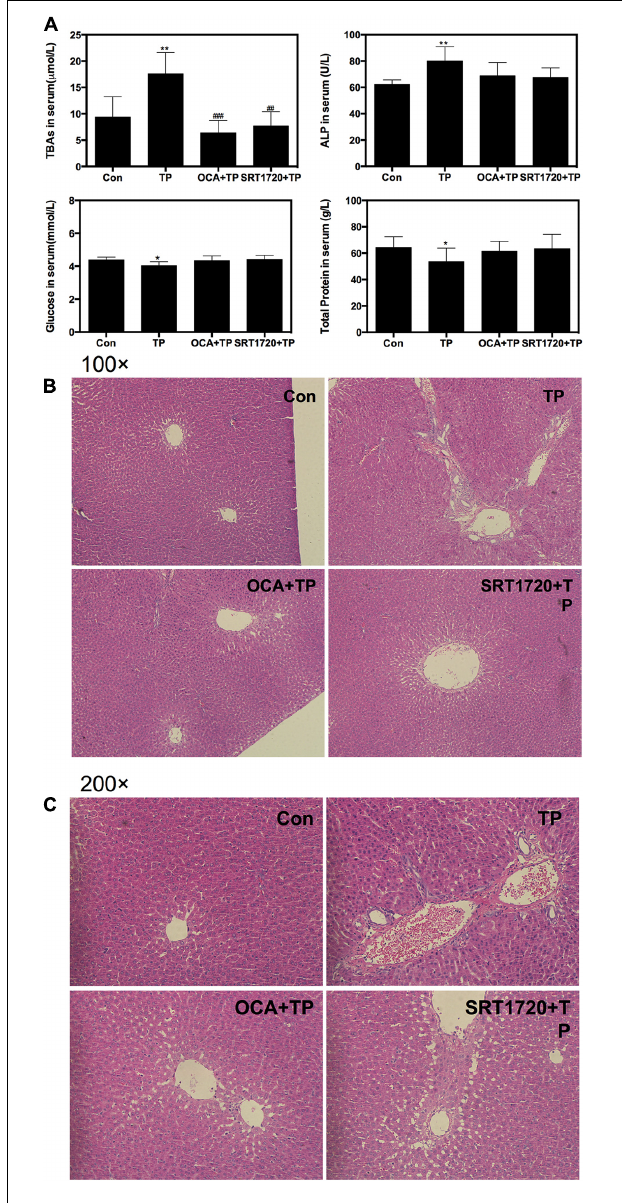
FIGURE 5 | Protective effect of Sirt1 on TP-induced hepatotoxicity in rat model. Female Wistar rats were treated as previously described in the Materials and Methods. (A) The serum levels of TBA, ALP, glucose and total protein levels were measured. (B,C) Representative images of the HE staining of the rat liver sections. The images were recorded using an Olympus microscope equipped with a 100 × lens and 200 × lens using an image